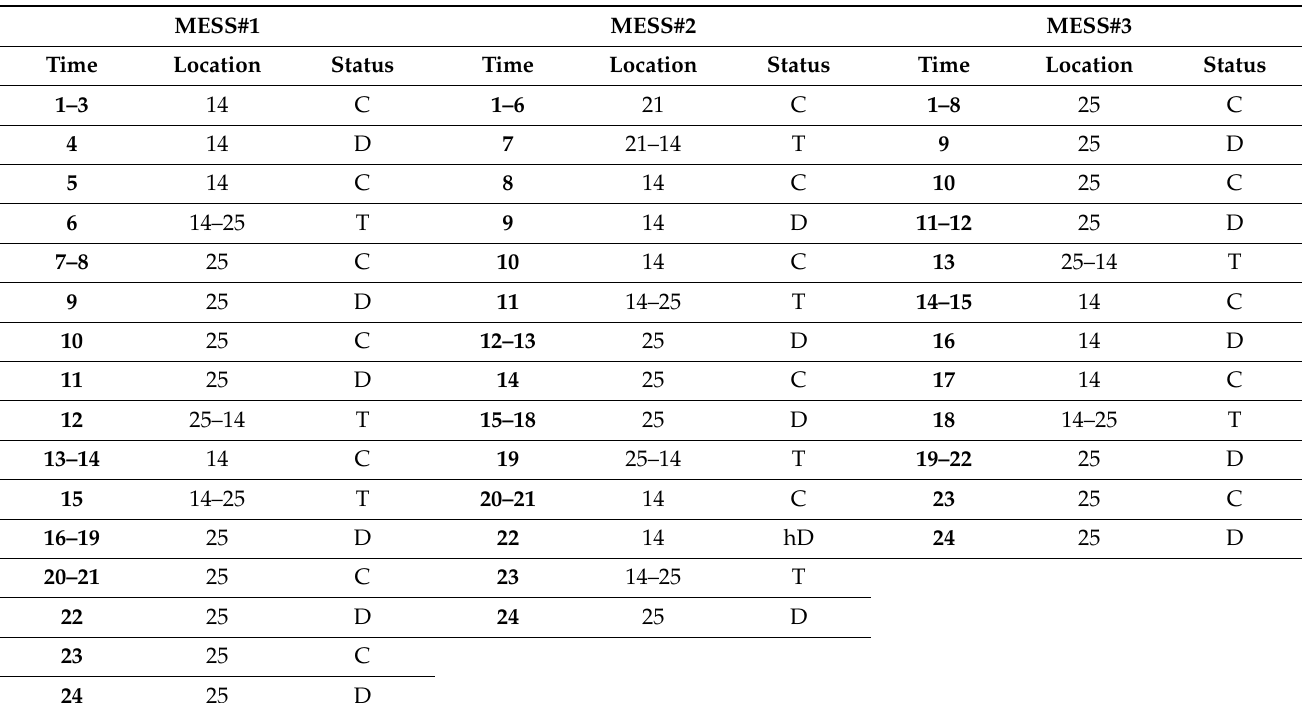
Figure 11. A modified 33 ‐ bus IEEE distribution with islanding MGs. Table 6. Status and location of